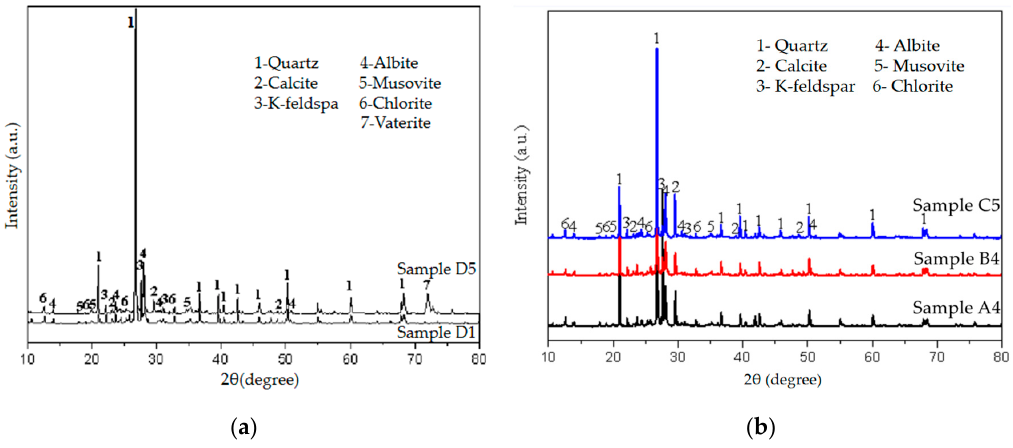
Figure 15. XRD results for ( a ) D1 and D5 and ( b ) A4, B4, and C5.